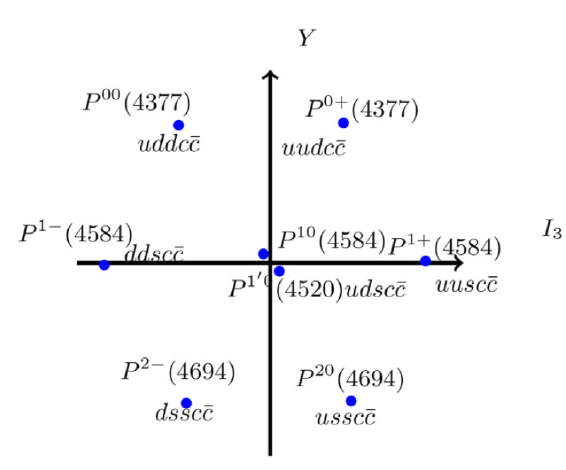
Figure 2. Octet of the charmonium pentaquark states. A pentaquark state is denoted with P ij ( M